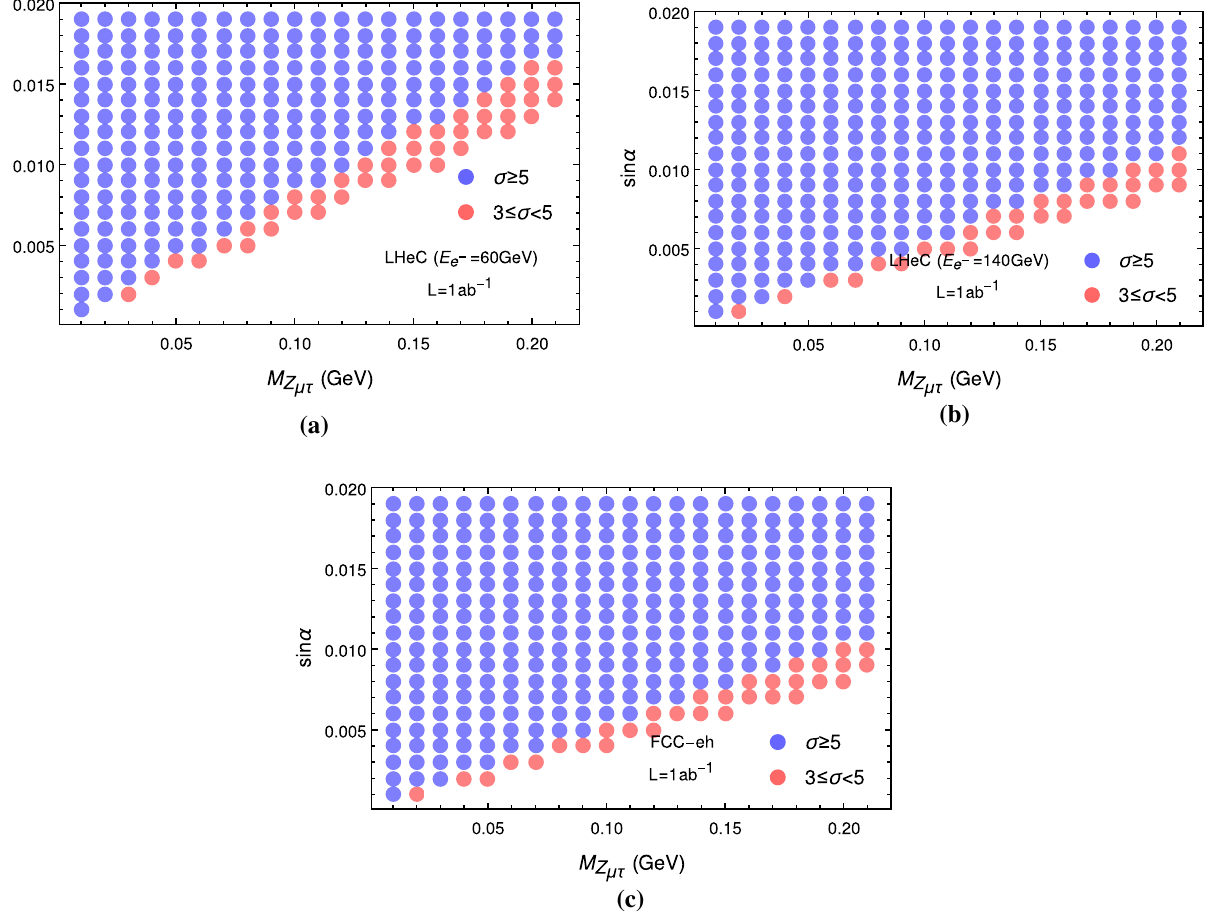
Fig. 9 3 σ and 5 σ detection regions for the signal-2 at the LHeC with E e − = 60 GeV ( a ), LHeC with E e − = 140 GeV ( b ) and FCC-eh ( c ) with an integrated luminosity of 1 ab − 1 ,